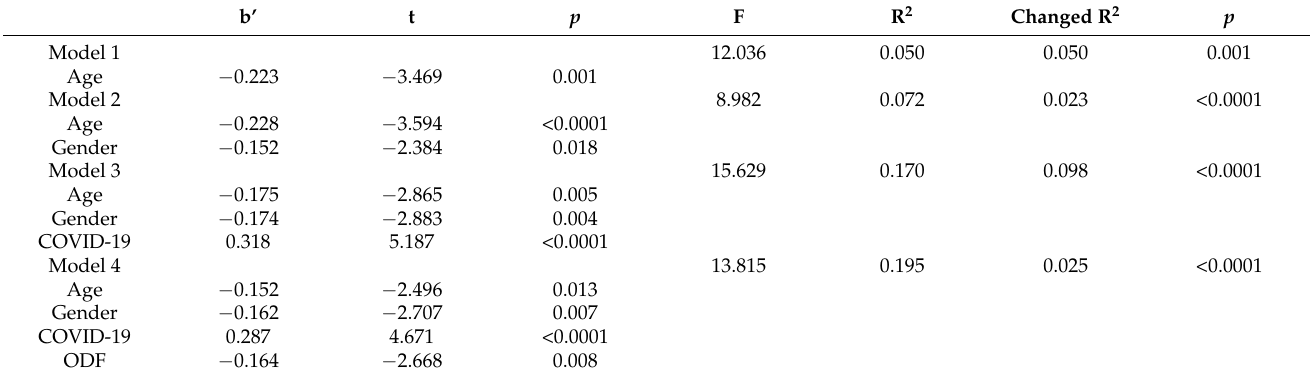
Table 6. Hierarchical regression analysis of predictors of depersonalization ( N =